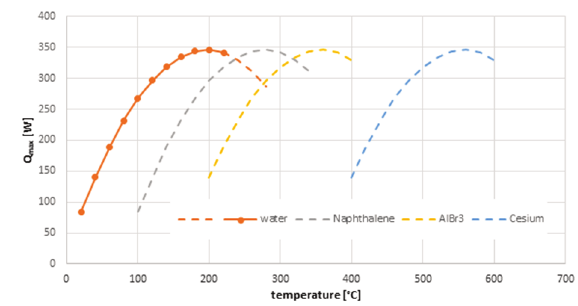
Fig. 6. Curves Q max = f(operating temperature) for analysing the type of working fluid Basing of the above figure, transferred heat power was